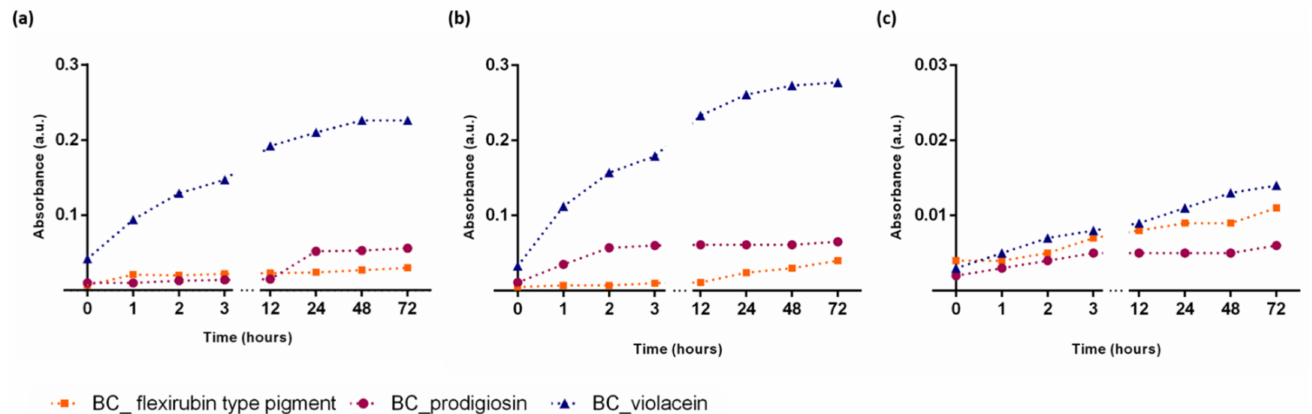
Figure 2. Evaluation of violacein, prodigiosin, and flexirubin-type pigment release from the color indicator in food simulant solutions: 95% ethanol, to represent fatty food ( a ); 50% ethanol, represents oil-in-water emulsion food ( b ); and 10% ethanol, to represent aqueous food ( c ). The release rate was evaluated spectrophotometrically, at 535 nm for BC_prodigiosin, 585 nm for BC_violacein, and at 450 nm for BC_flexirubin